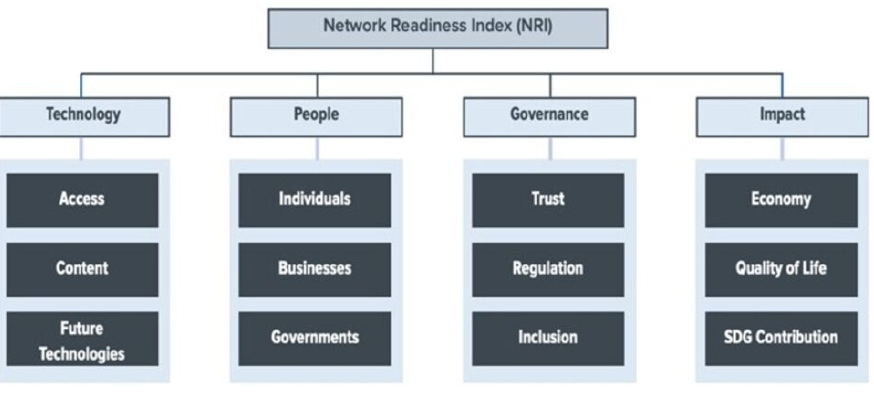
Figure 4. The Network Readiness Index [12] (p. 31).